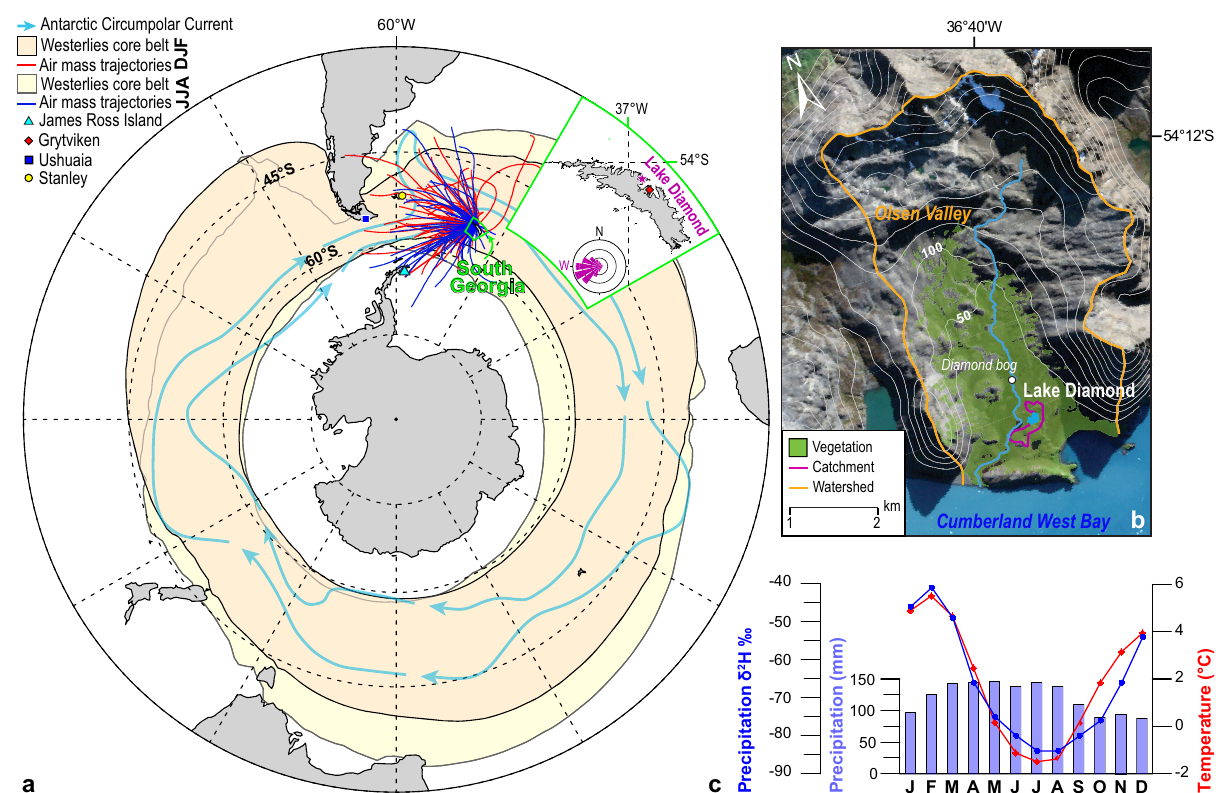
Fig. 1 Key localities and observations. a Overview map of the Southern Ocean with an inset of South Georgia, highlighting Lake Diamond as well as the nearest weather stations of Grytviken, Ushuaia, and Stanley in color coding that corresponds with Fig. 2. The average position and extent of the Southern Westerlies core belt, de fi ned as areas where mean zonal wind speeds exceed 5 m/s − 1 between 1981 – 2010 CE 122 , is shown for the Austral summer (DJF) and winter (JJA). The purple wind rose shows the prevalence of this dominant wind system. Forty-eight hours daily backward air mass trajectories from 2019 are shown for summer (red) and winter (blue) 123 . The long-term position of the Antarctic Circumpolar Current (ACC) is delimited in cyan by the Antarctic convergence to the South and the Sub-Antarctic front to the North after 124 . b Close-up of the Lake Diamond catchment and the wider Olsen valley as modi fi ed after 29 . Vegetated areas, de fi ned as surfaces with normalized difference vegetation index (NDVI) values >0.3 during the growing season (January 2020) 33 , are highlighted in green. Sentinel-2 satellite image courtesy of the ESA Copernicus Open Access Hub. c Long-term monthly local climatology based on 1905-2012 CE station data from nearby Grytviken 23 and spatial δ 2 H interpolation 42